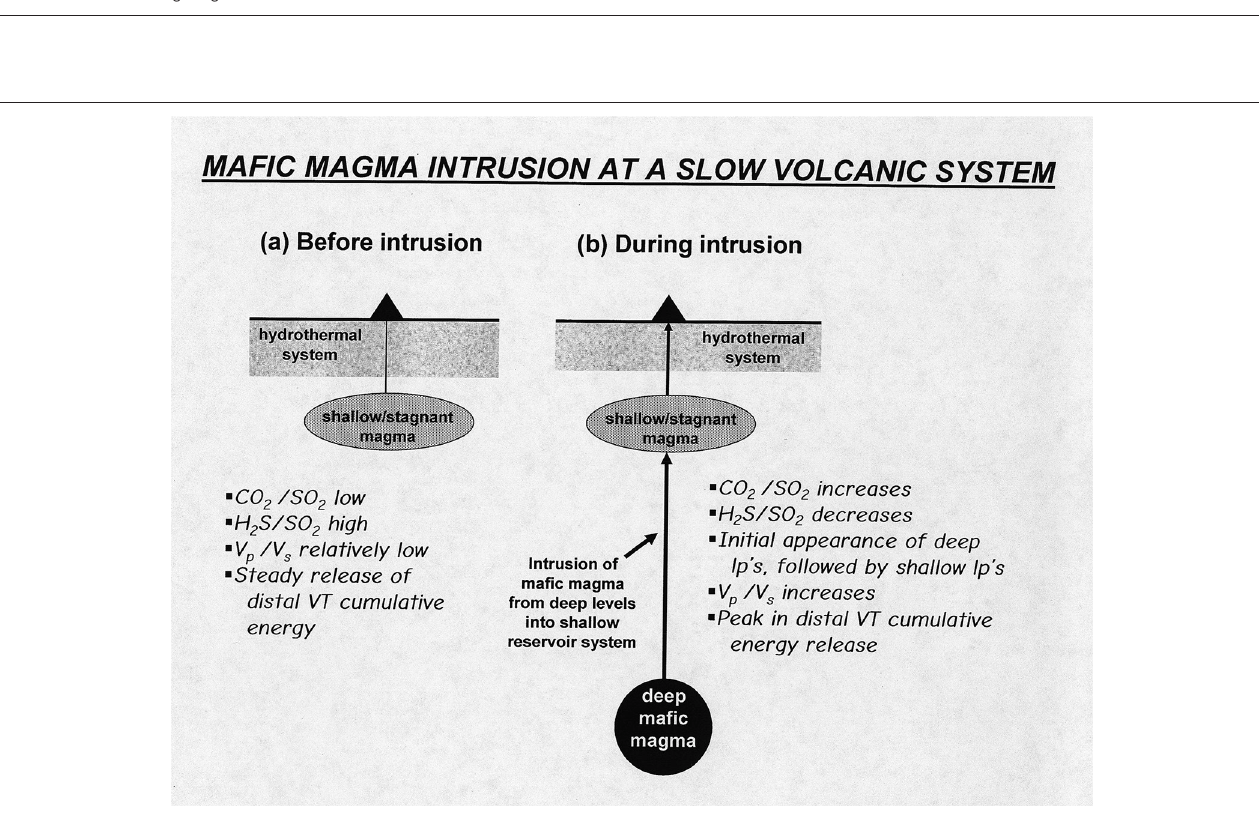
FIGURE 9 | A conceptual depiction of geochemical and geophysical change associated with intrusion of more mafic magma from deep levels at a volcano with slow activity.